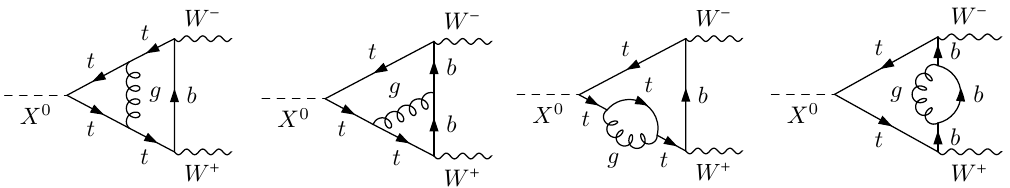
Figure 1. Representative two-loop Feynman diagrams contributing to the X 0 W + W (cid:0) interaction, where X 0 = H; Z; (cid:13) (cid:3) . Similar diagrams where t and b quarks are exchanged are also taken into account. The diagrams have been generated using FeynArts